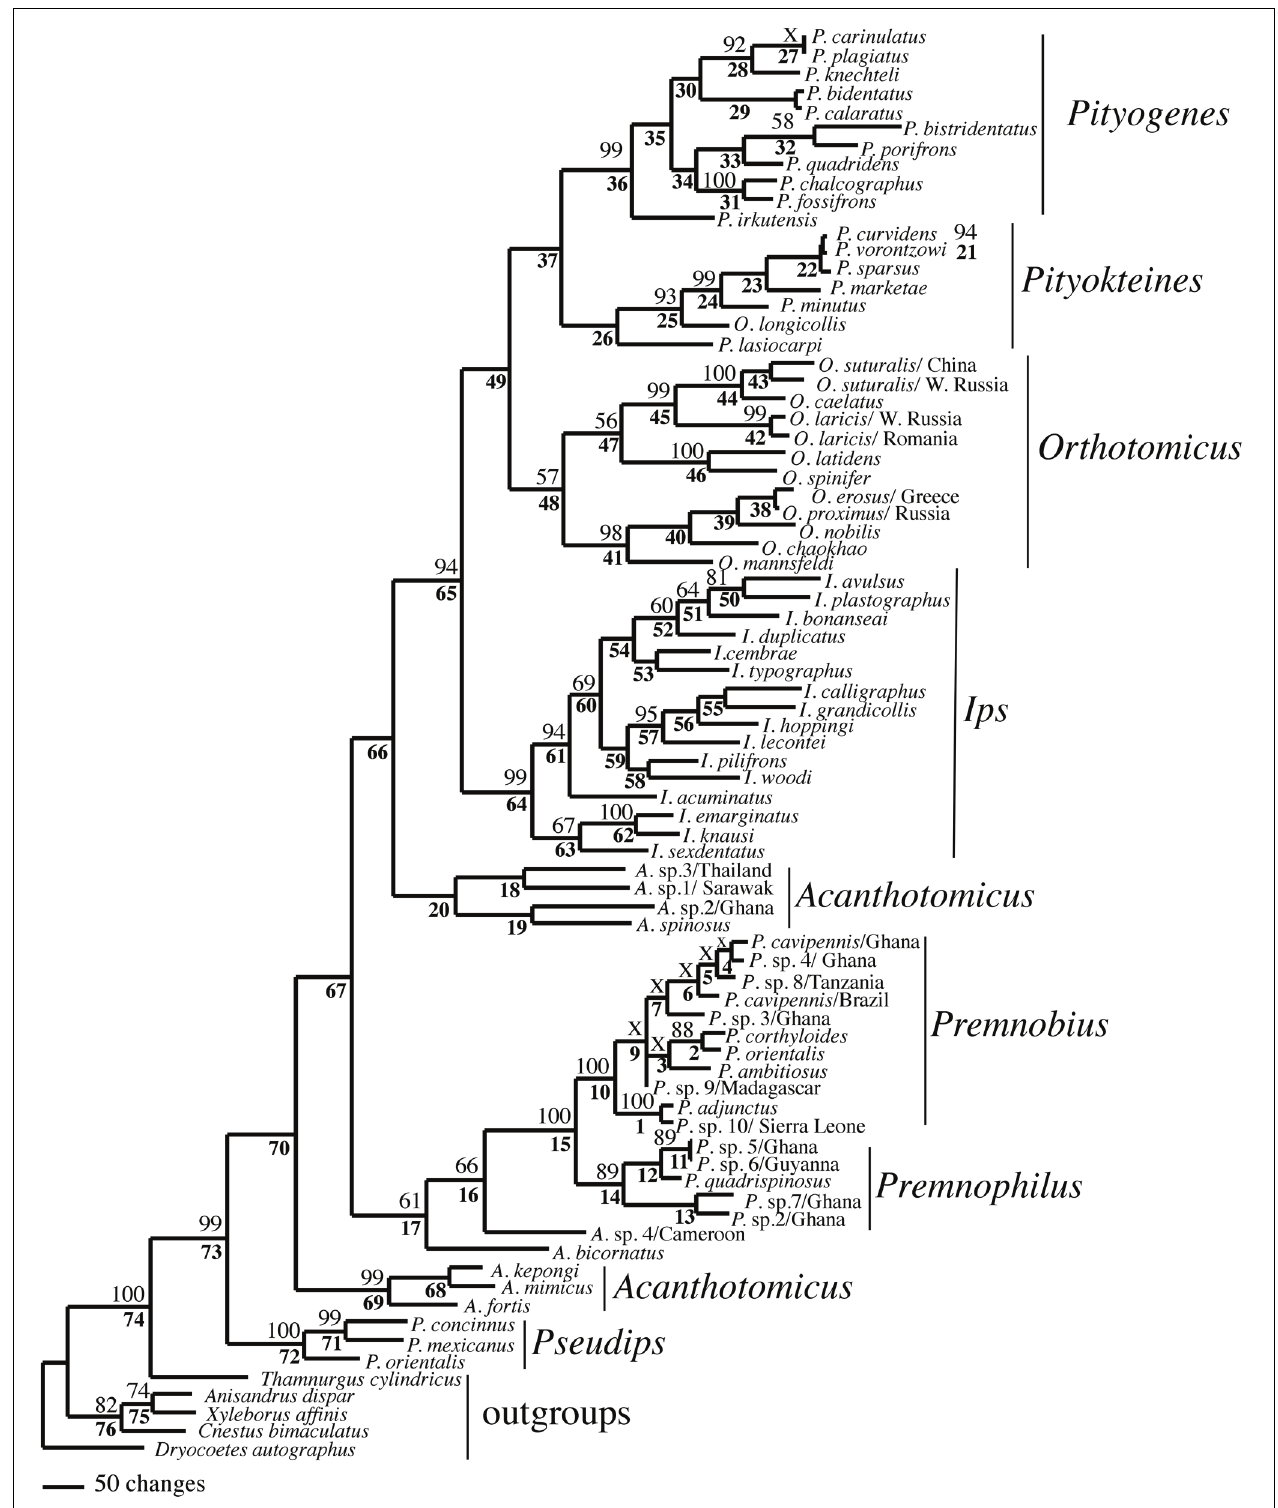
FIGURE 1 | Phylogeny of Ipini and outgroup species; 1 of 87 most parsimonious trees based on the manually aligned data. Clades marked by “X” were not resolved in the strict consensus of the